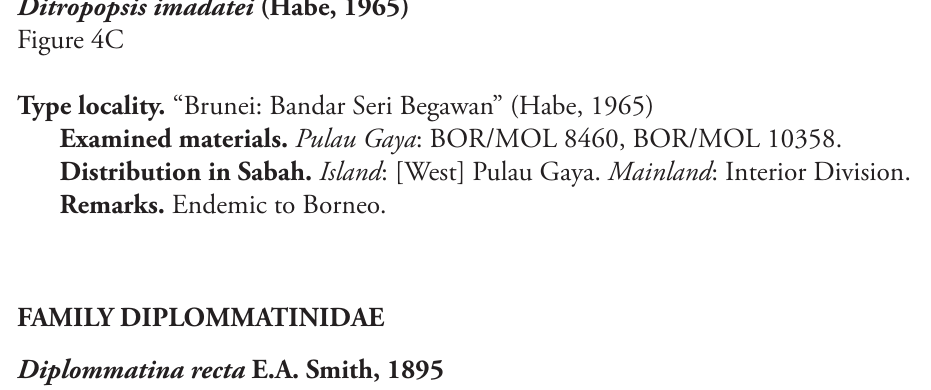
Type locality. Not applicable. Examined materials. Pulau Rusukan Besar : BOR/MOL